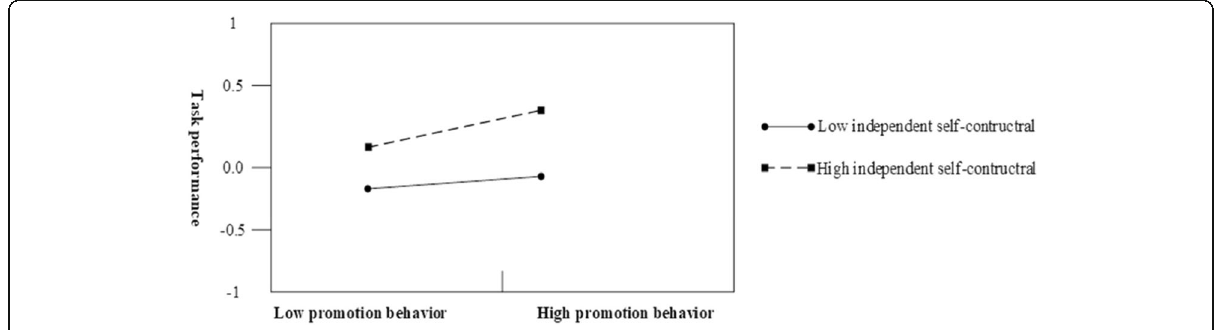
Fig. 5 Moderating effect of independent